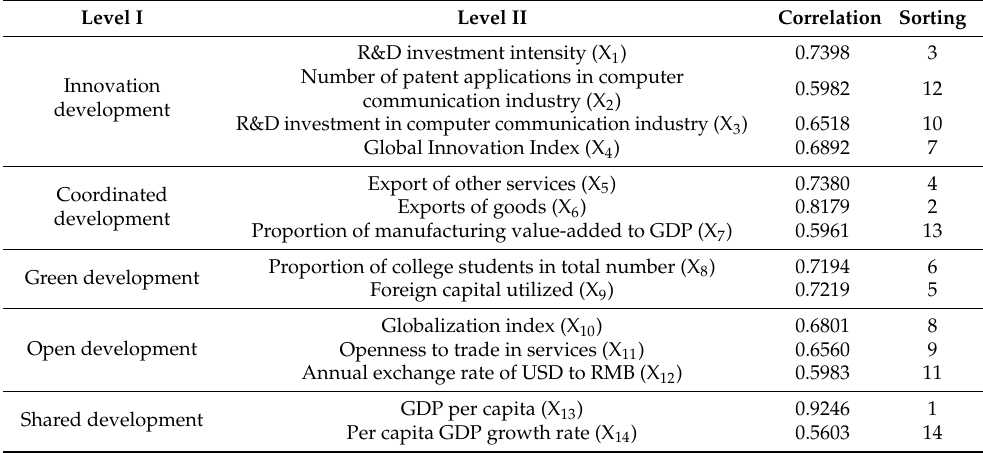
Table 5. Grey correlation degree between the influencing factors indicators of the international competitiveness of China’s computer information service industry and its RCA value.